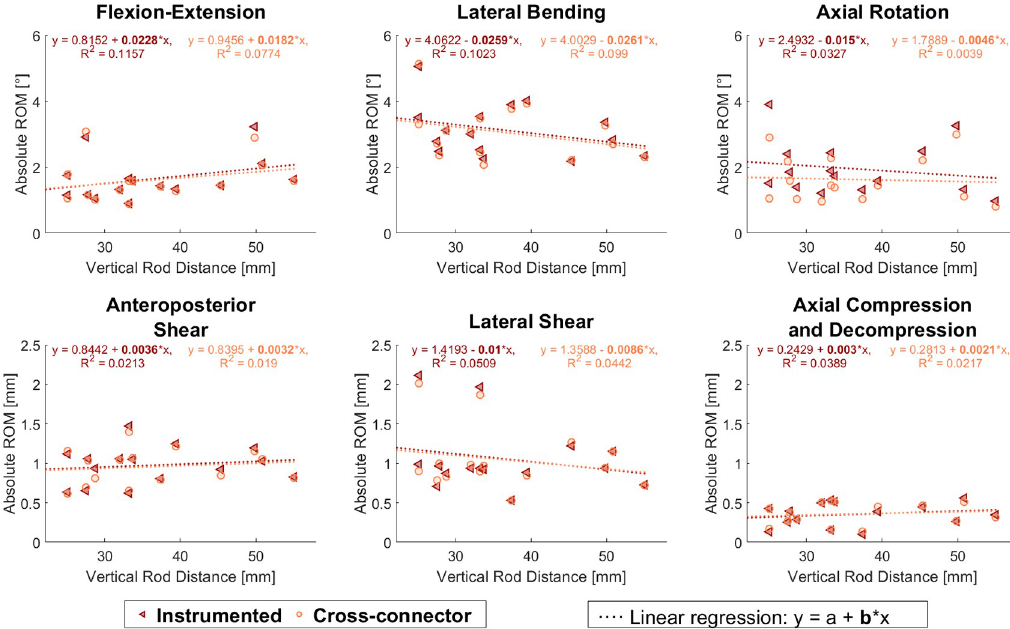
Fig 5. Rod-rod distance. Scatter plot for the range of motion (ROM) over the rod-rod distance for instrumented (triangles) and cross-connector-configuration (circles) shown for all six loading directions. No statistically significant correlations were observed. Linear regression fit and their parameters are reported to illustrate the data distribution. Figure generated by the